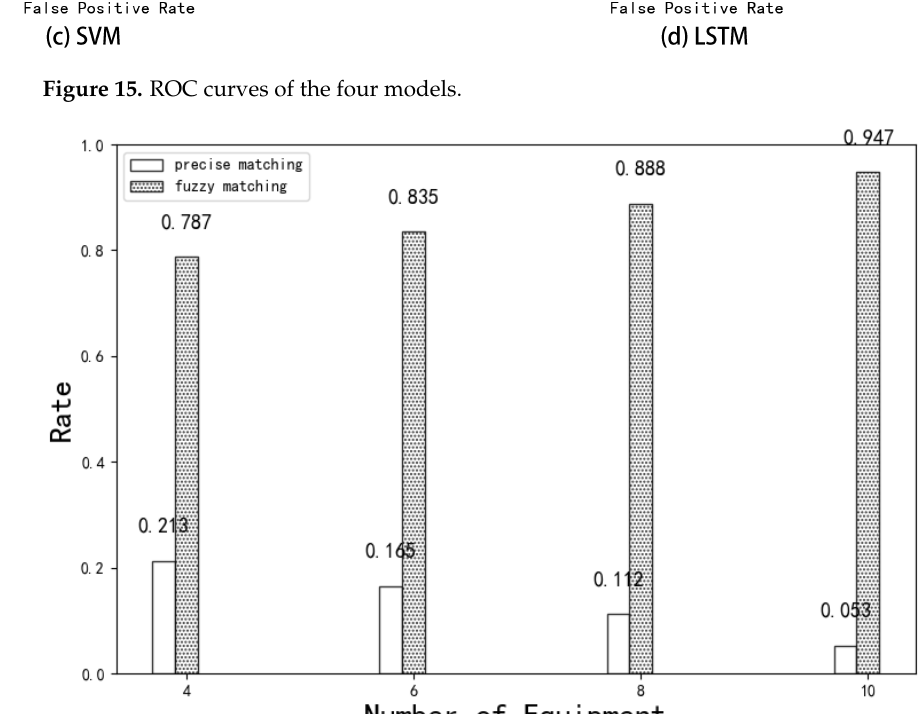
Figure 16. Comparison of exact matching and fuzzy